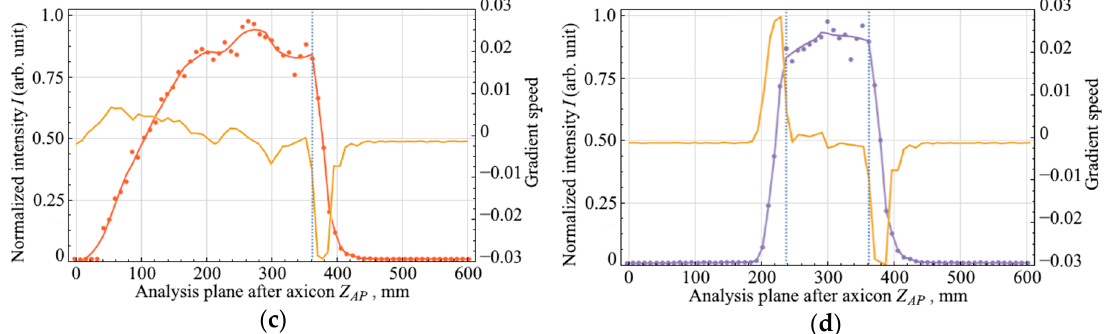
Figure 3. Axial intensity distributions of a zero-order Bessel beam and gradient from the longitudinal coordinate AP